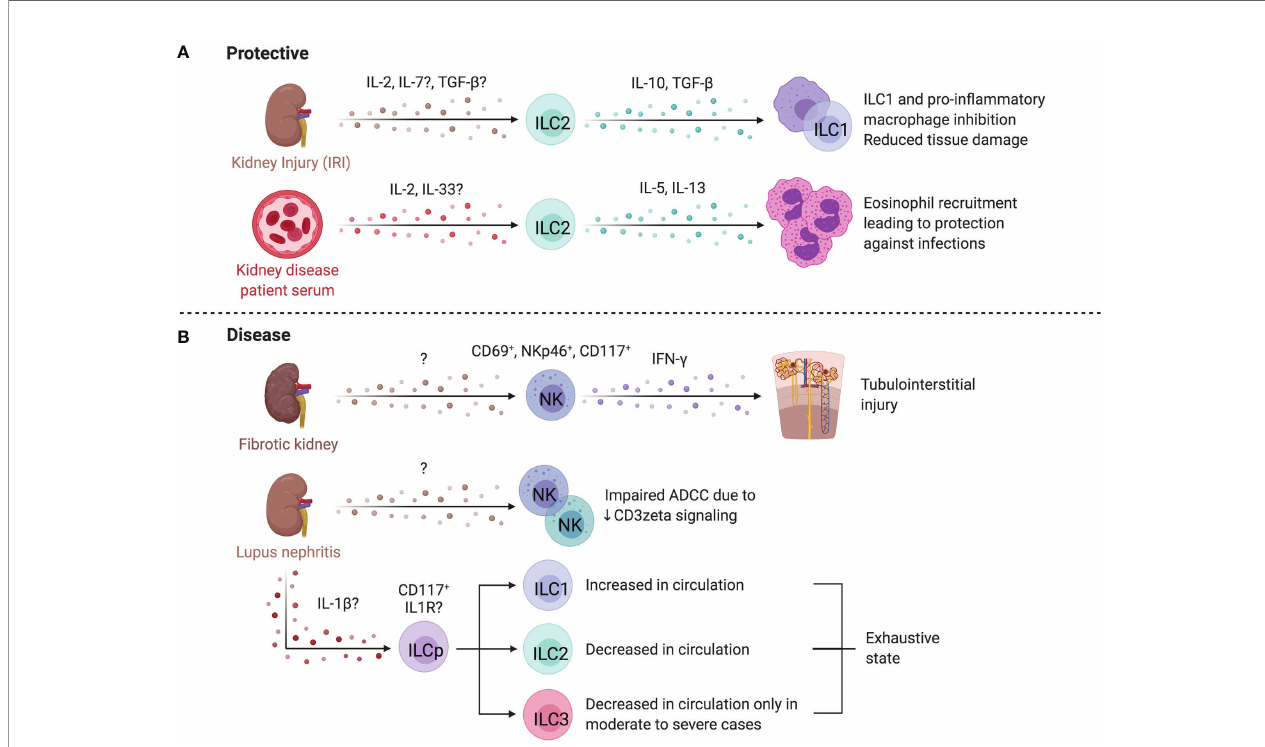
FIGURE 8 | ILCs in the kidney. (A) Mouse and human studies support ILC2s may limit kidney injury. Administration of IL-25 and IL-33 in a humanized mice model attenuates IRI, and in conventional mouse models promotes a Th2 response and M2 macrophage polarization resulting in decreased tissue damage post ischemic injury. ILC2s may also be protective in end-stage renal disease (ESRD), where circulating ILC2 abundance, proliferation, and cytokine release increases. IL-2 is proposed to facilitate this ILC2 expansion via STAT5 and protect against infections through eosinophil support. (B) CD56 bright NK cells are more abundant in fi brotic kidney tissue where they upregulate CD69 and co-express NKp46 and CD117, producing the majority of IFN- g , implying a role in driving in fl ammation and fi brosis. In lupus nephritis (LN), scRNAseq revealed two distinct NK cell subsets – a CD56 dim CD16 + blood-derived and tissue-resident CD56 bright CD16 - population. Both NK cells showed impaired antibody-dependent cell cytotoxicity because of dampened signaling ef fi ciency by NKp30 and NKp46. LN patients further displayed elevated ILC1s and decreased ILC2s, while patients with moderate to severe disease showed an additional decrease in ILC3s. Created with